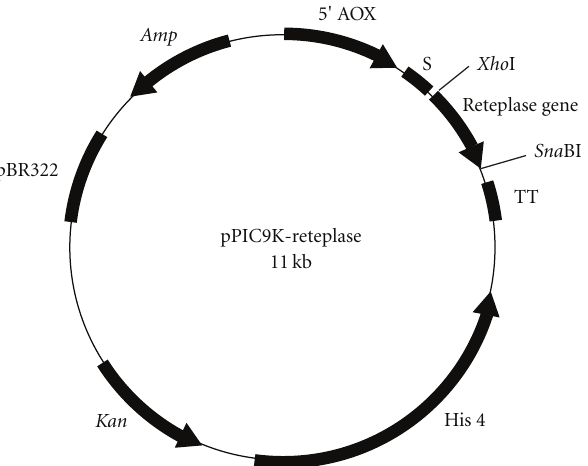
Figure 1: Plasmid map of